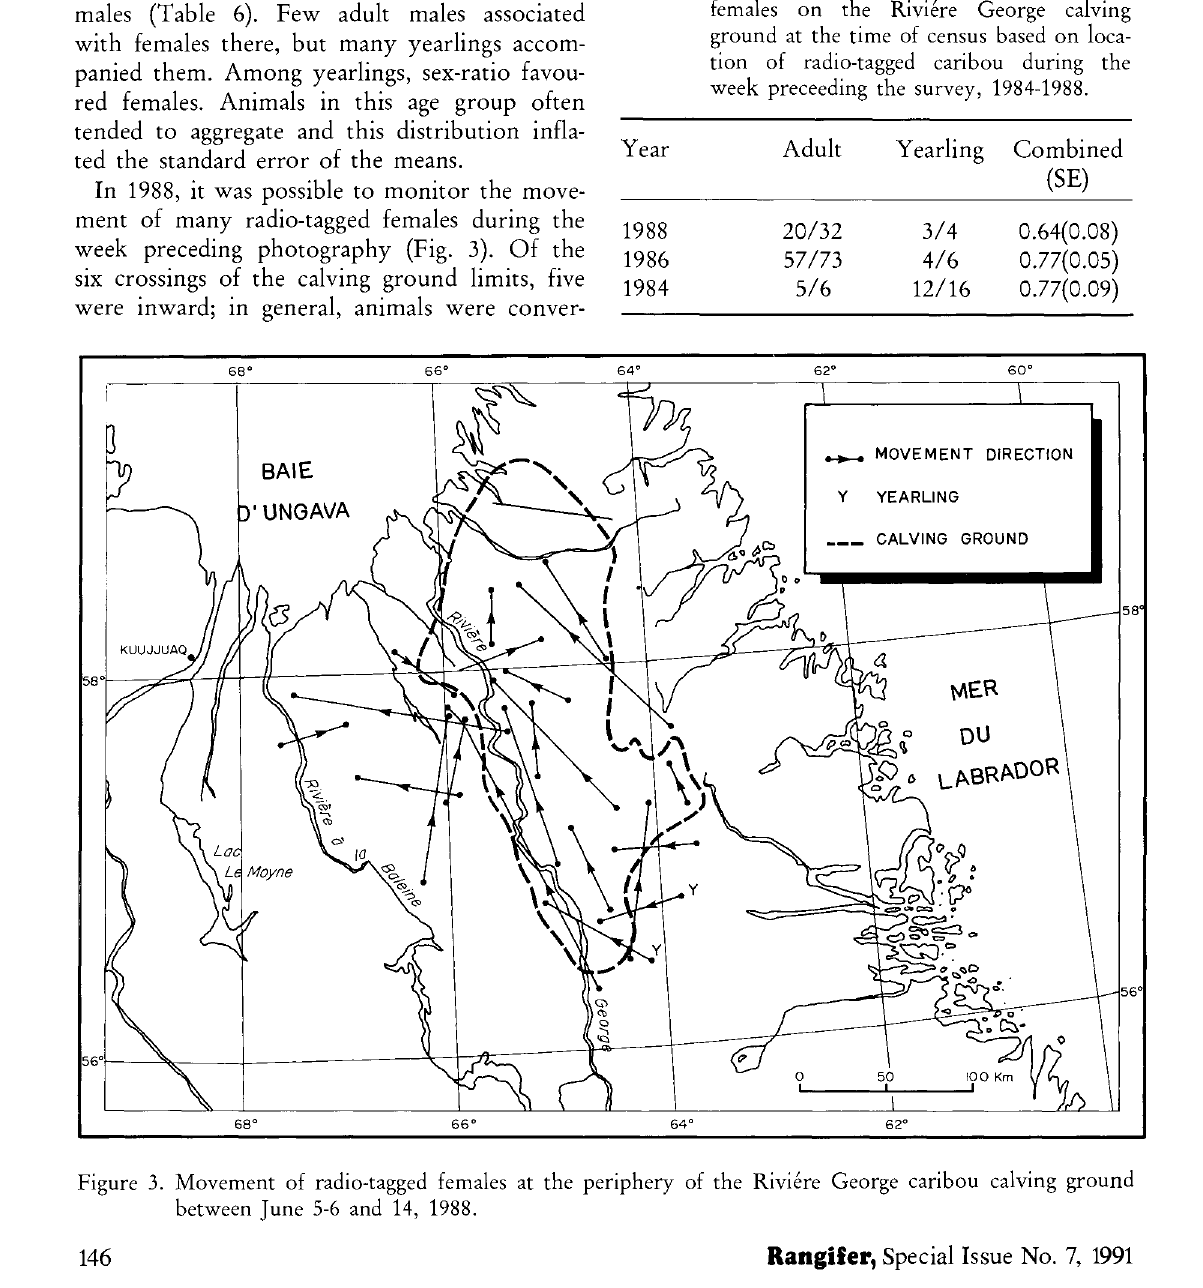
Figure 3. Movement of radio-tagged females at the periphery of the Riviere George caribou calving ground between June 5-6 and 14,